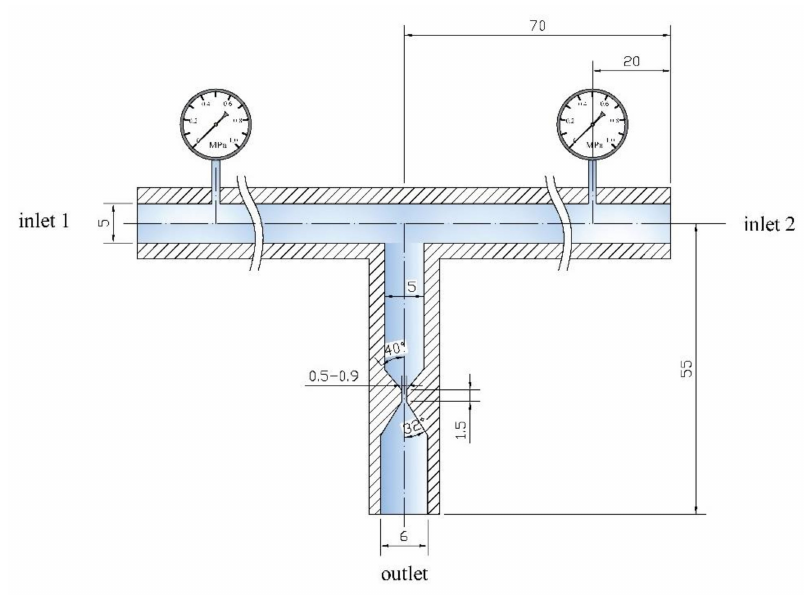
Figure 2. Schematic diagram of the impact-jet hydraulic cavitator. (The unit of length marked in the figure is mm.)